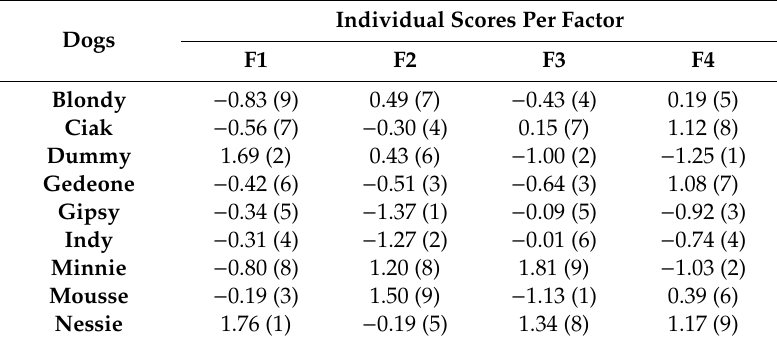
Table 4. Dog individual score (their order in brackets) for each